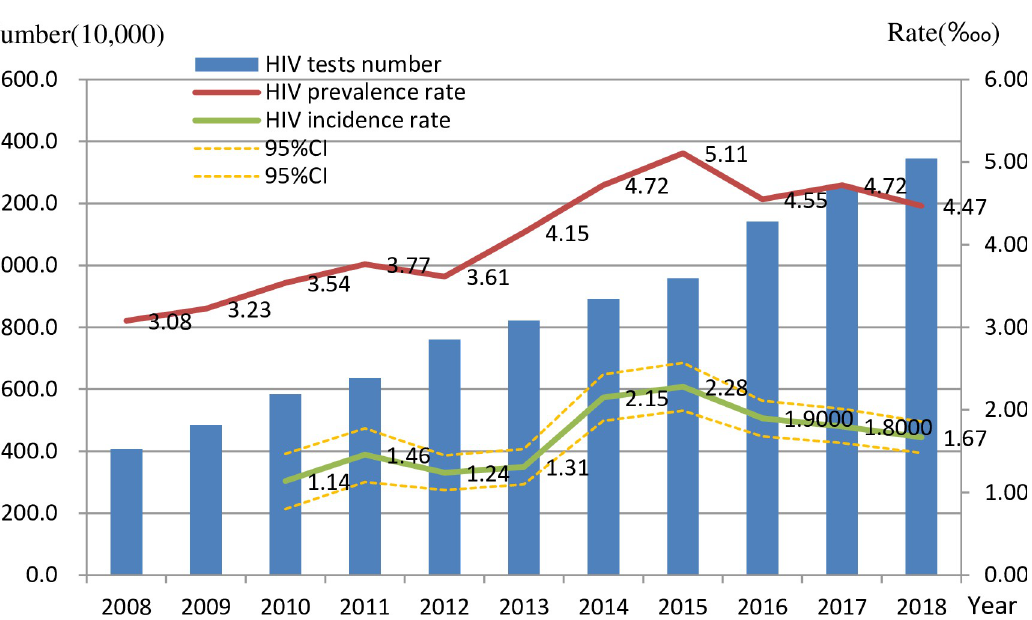
Fig 2. Number of HIV testing, rate of HIV-positive and HIV incidence rate in Zhejiang province between 2008 to 2018. This figure shows the change of HIV testing number, HIV prevalence and HIV incidence in whole population.